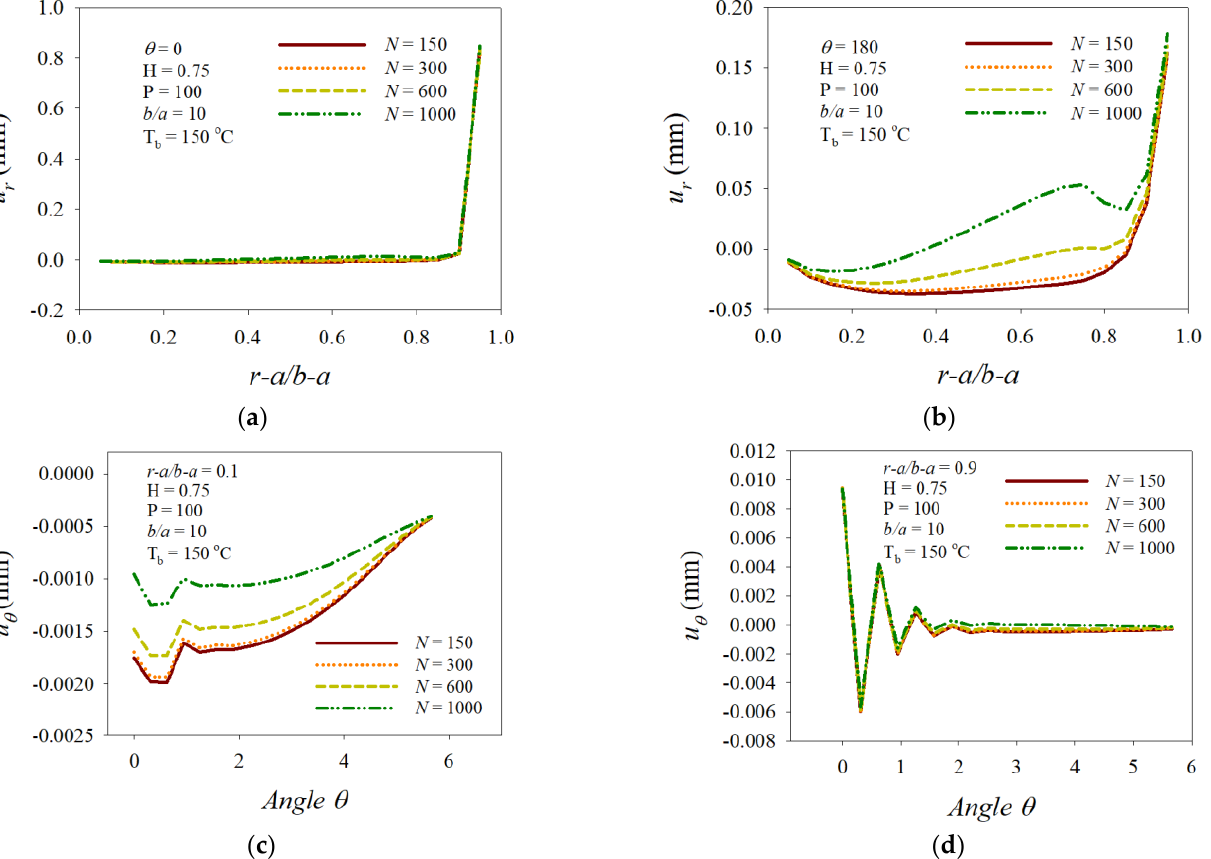
Figure 7. Effects of angular velocity on the components of displacement: ( a ) Radial at θ = 0 , ( b ) radial at θ = 180 , ( c ) circumferential at ( r − a)/(b − a) = 0.1, ( d ) circumferential at ( r − a)/(b − a) = 0.9.